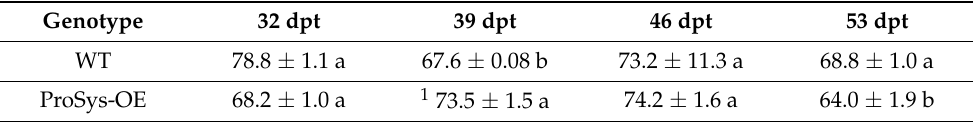
Table 2. Chlorophyll Content Index (CCI) in leaves of wild-type (WT) and prosystemin overexpress- ing (ProSys-OE) plants. CCI was determined in leaves of wild-type (WT) untransformed tomato plants and in plants overexpressing the ProSys precursor protein of the systemin peptide hormone. Measurements were made at 32, 39, 46, and 53 days post-transplantation (dpt) of seedlings into 5 L plant pots.